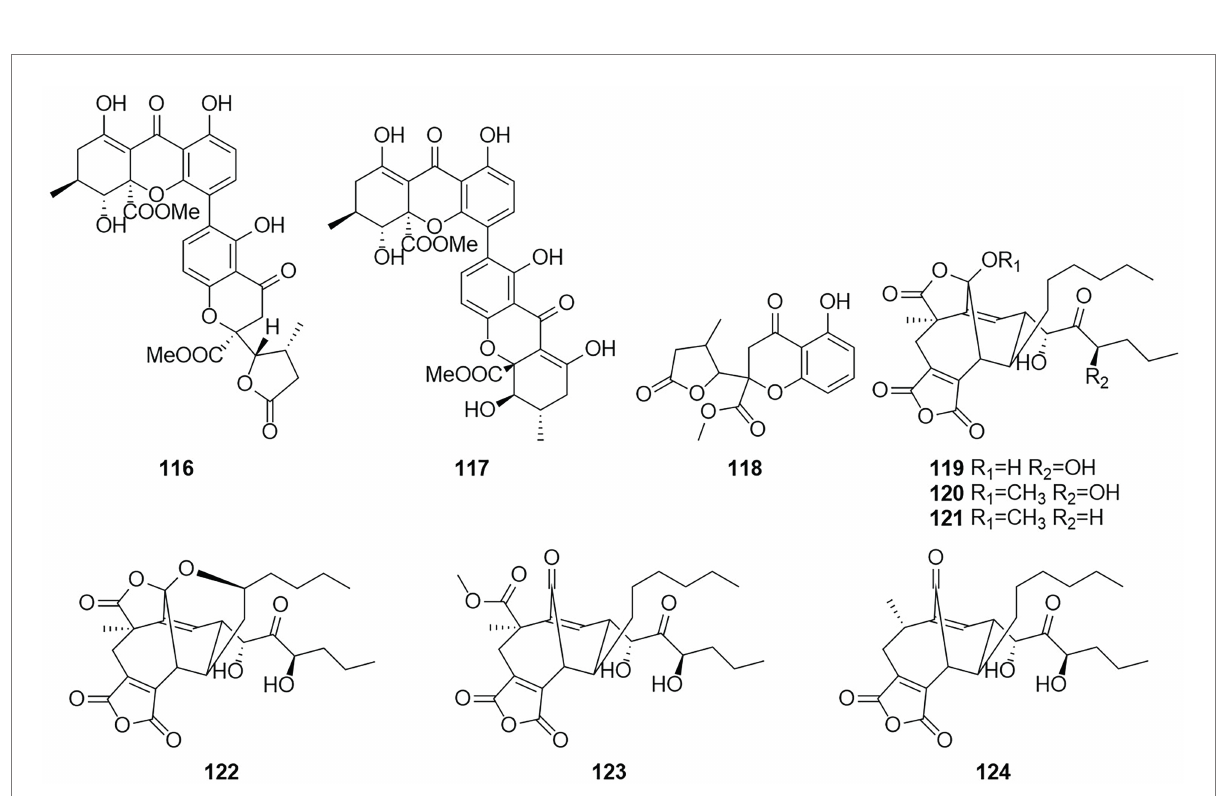
FIGURE 7 Chemical structures of compounds 116–124